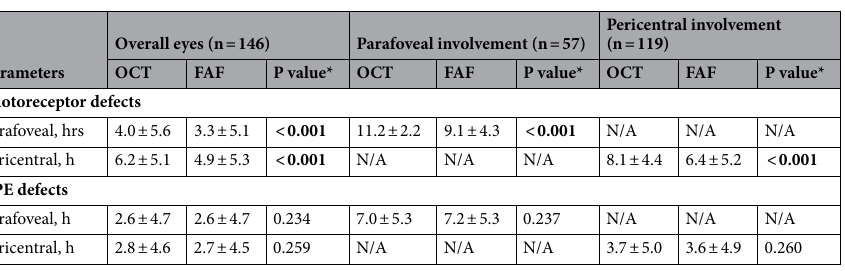
Table 2. Clock hour extents of photoreceptor and retinal pigment epithelium (RPE) damages on parafoveal and pericentral areas among those with parafoveal (n = 57 eyes) and pericentral involvement (n = 119 eyes) on optical coherence tomography (OCT) or fundus autofluorescence (FAF). Significant values are in bold. *Paired t test. N/A not applicable.